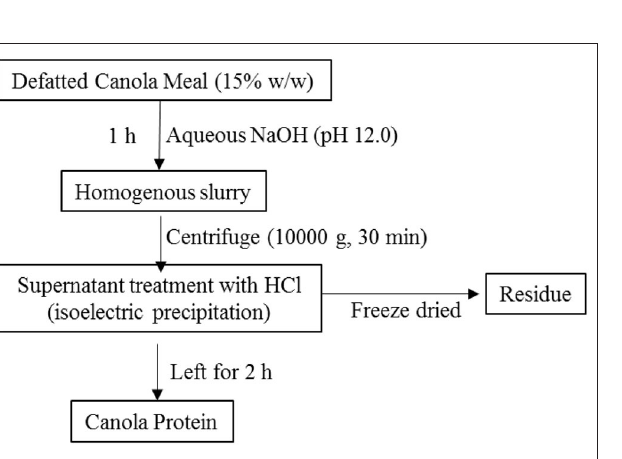
FIGURE 3 | Extraction of canola protein from defatted canola meal using alkaline